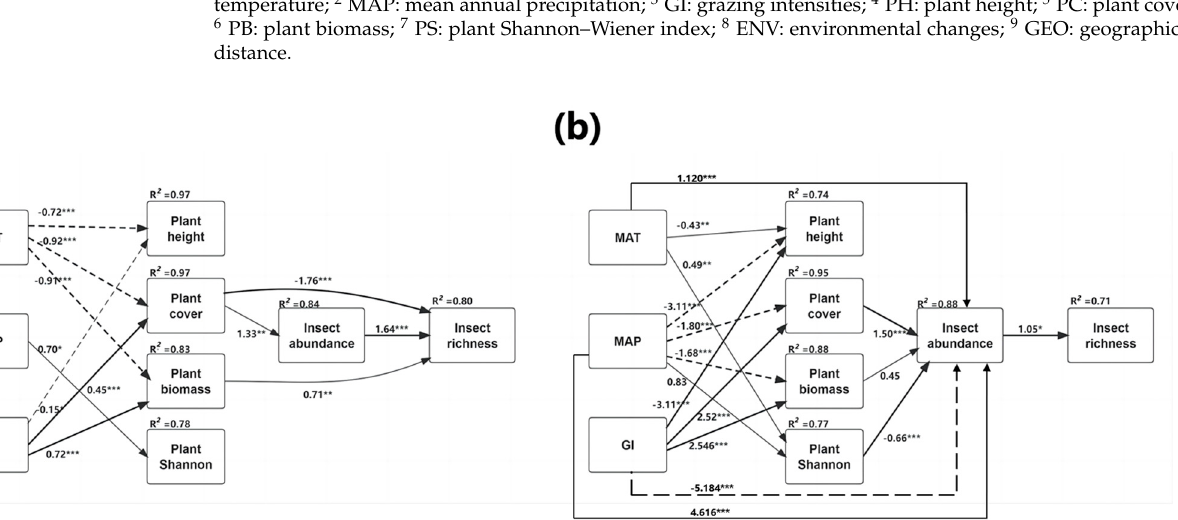
Table 2. Effects of different environmental factors in the Mantel test analysis for each of the two steppe types and the whole transect in EEST.